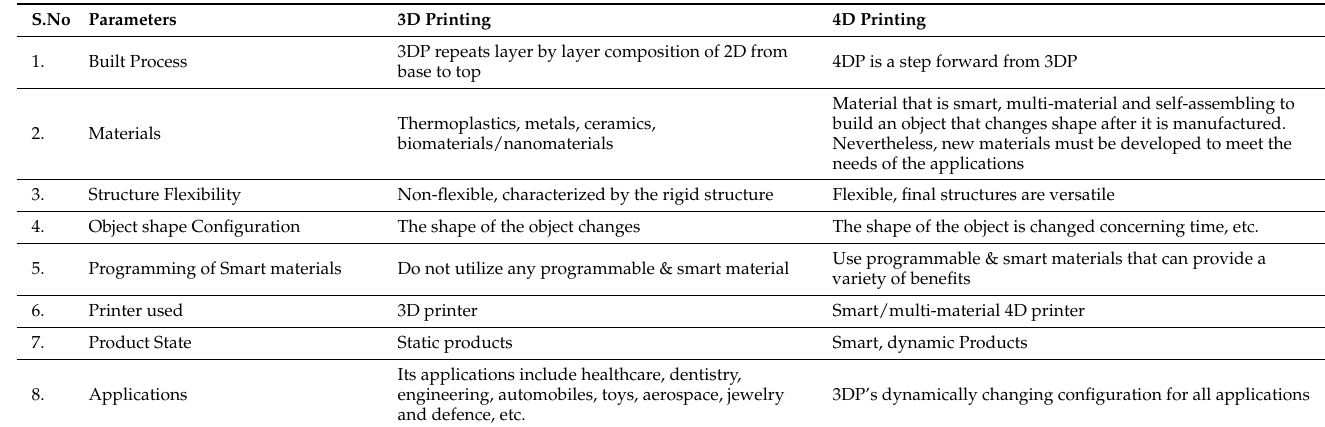
Table 2. Evolution of 4D printing from 3D printing. 4D P has evolved from 3D printing. The